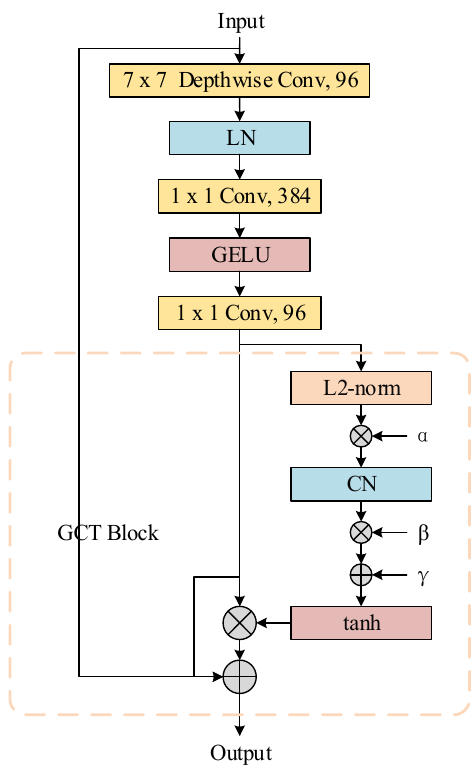
Figure 2. The structure of the improved ConvNeXt block.